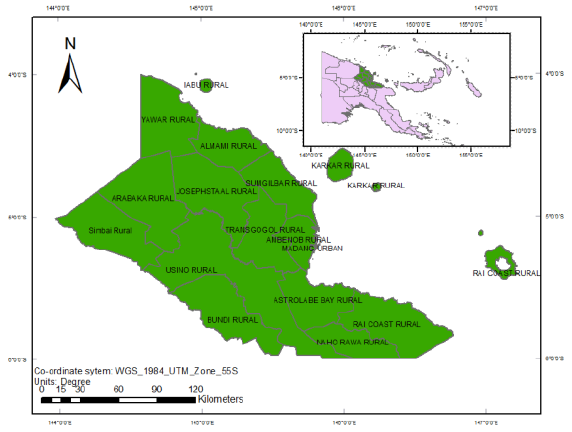
Figure 2. Location map of Madang province, Papua New